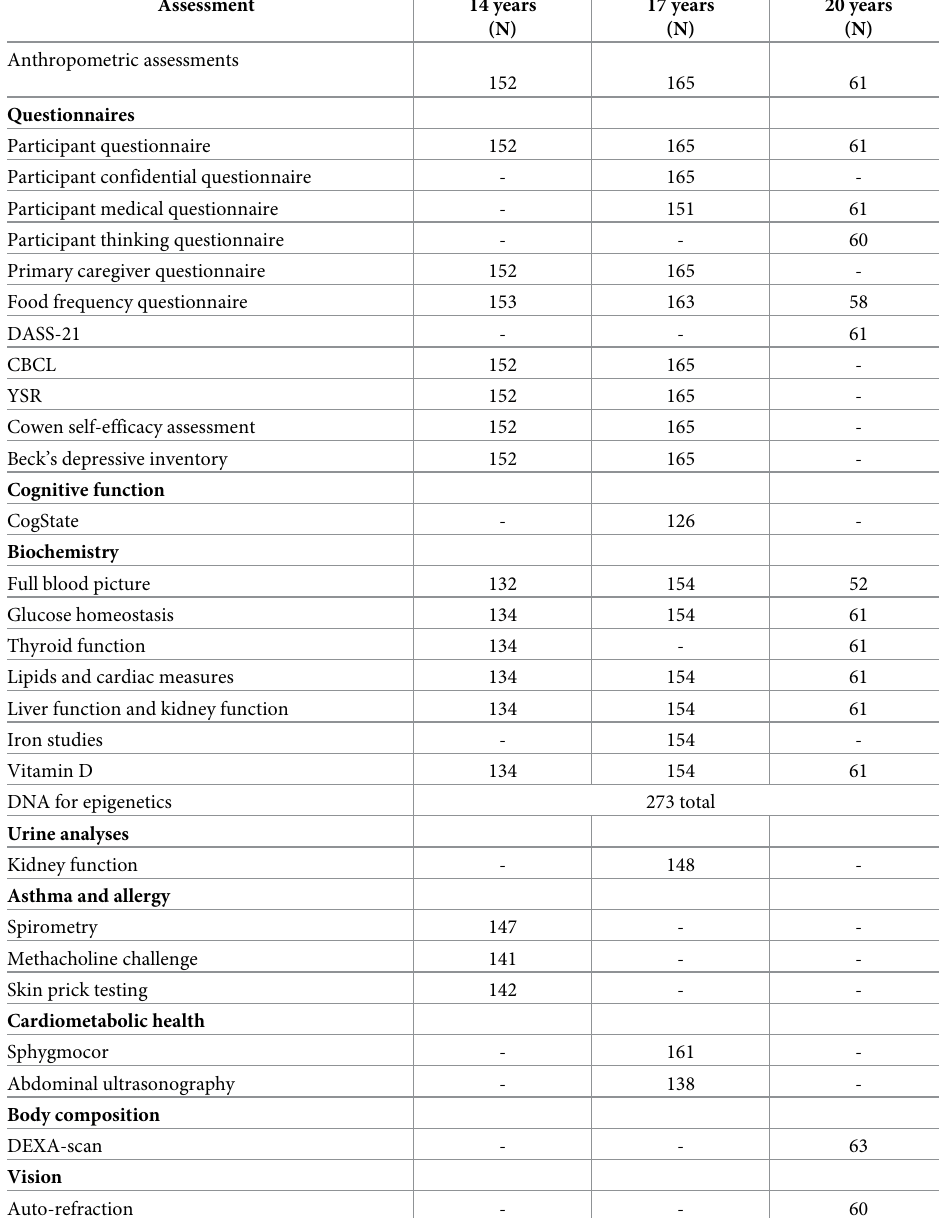
Table 1. Overview of conducted assessments per follow-up.